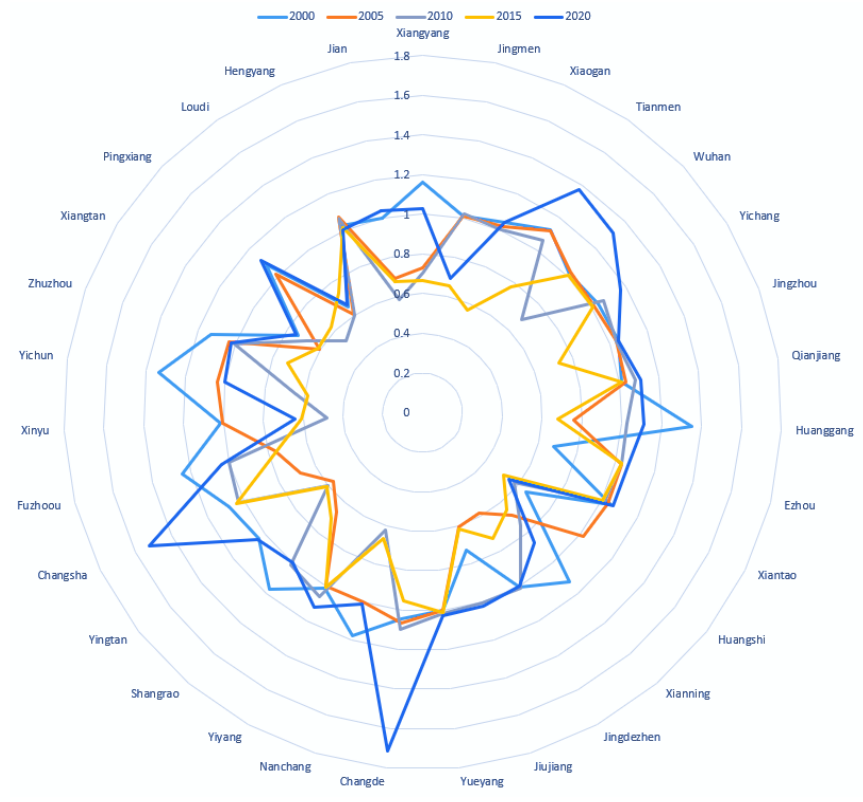
Figure 4. The results of the Ecological Efficiency of land